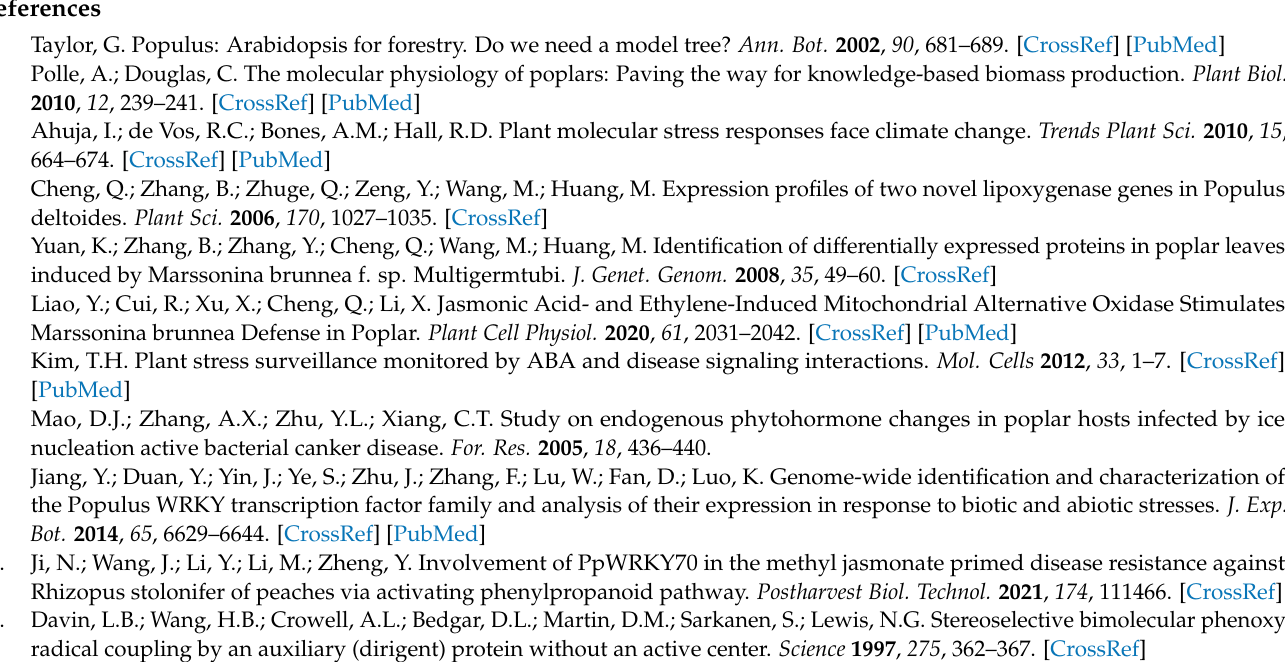
Figure 1, Table S1: List of primers for the RT-qPCR analyses, Table S2: Sequences of 10 predicted motifs of the PtDIR proteins, Table S3: Ka/Ks analysis of PtDIR gene pair duplications, Table S4: Transcription factors predicted for the binding promotors of the PtDIR